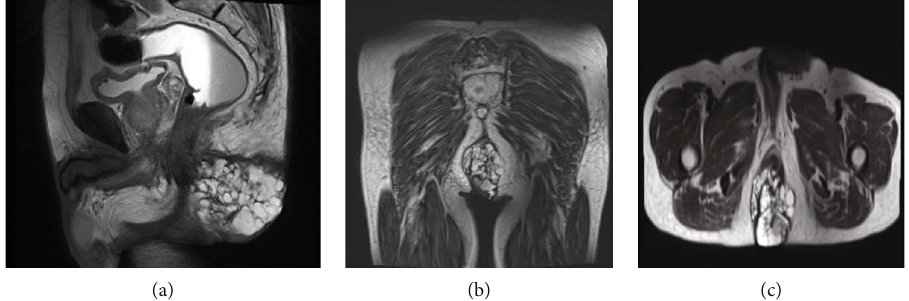
Figure 1: (a – c) MRI of the pelvis showing large mass involving the anal sphincter.